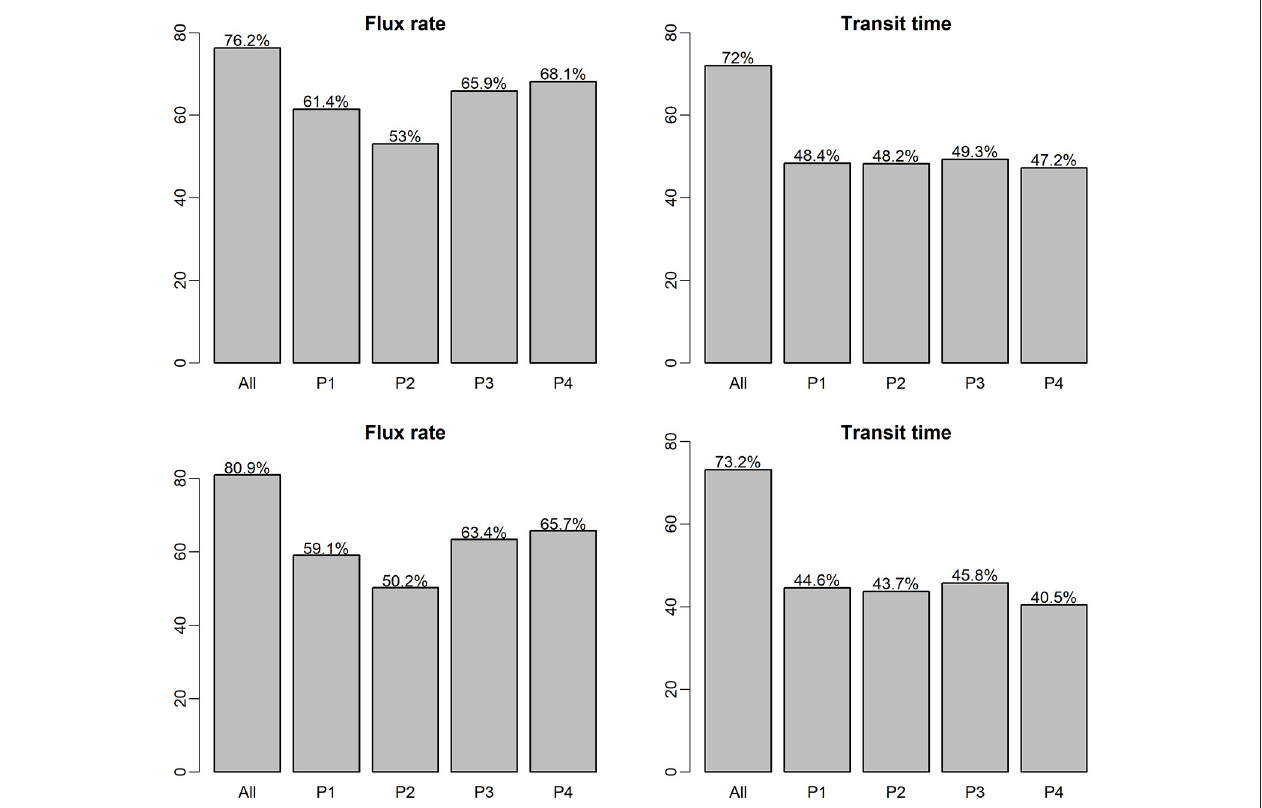
FIGURE 5 | ML model prediction R 2 on testing dataset for single-ML and flow regime-specific ML models, the top panel is RF model, the bottom panel is based on XGB model.